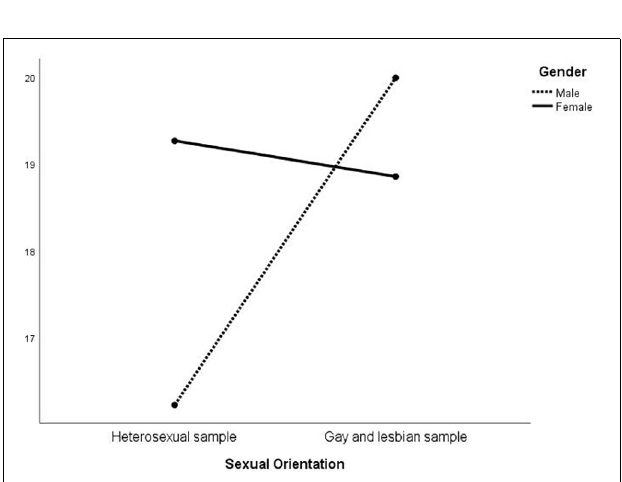
FIGURE 5 | Interaction of gender × sexual orientation on EIQ F5. Explicit